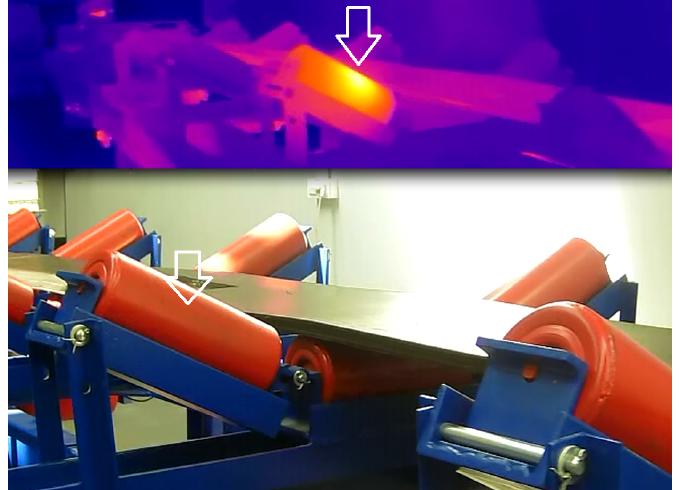
Figure 24. An infrared thermography image and RGB image fusion for one of idler with significantly higher temperature.